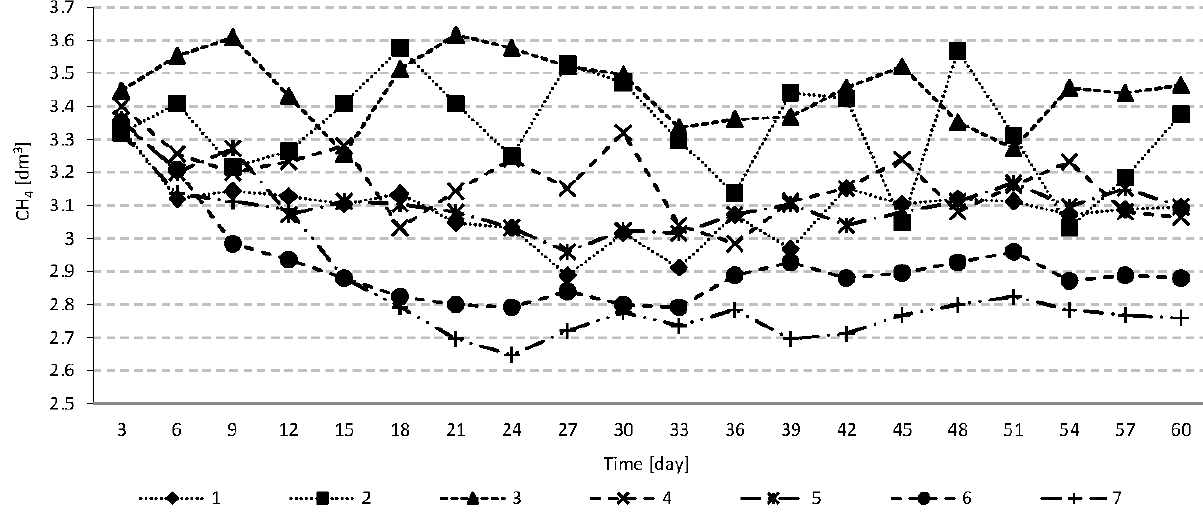
Figure 4. The course of CH 4 production during the experiment.